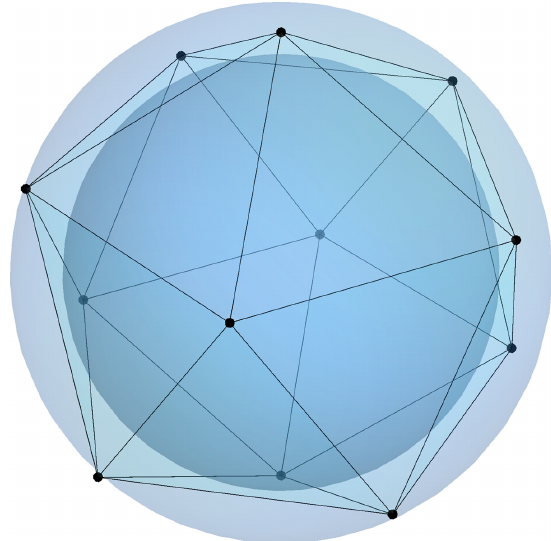
FIG. 2. Representation of the method for d = 2. Each vertex on the Bloch sphere represents a measurement operator. To every (cid:7) 0 | y we associate a corresponding antipodal inside the set enclosed by conv ( M ) can be simulated by mixing these extremal ones. In particular, any measurement { (cid:7) ball with radius η inscribed in the polytope is simulatable in such